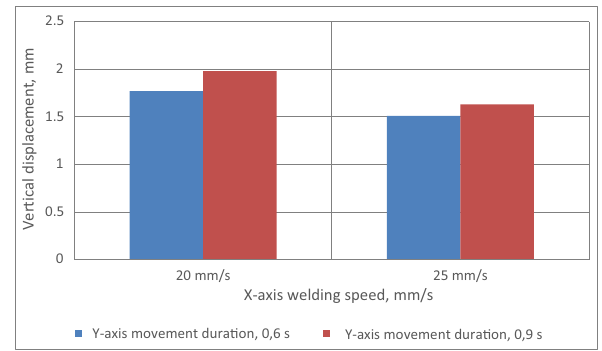
Figure 9: The e ff ect of y - axis movement duration and x - axis welding speed on the angular distortion of 20 mm wide weld plates.